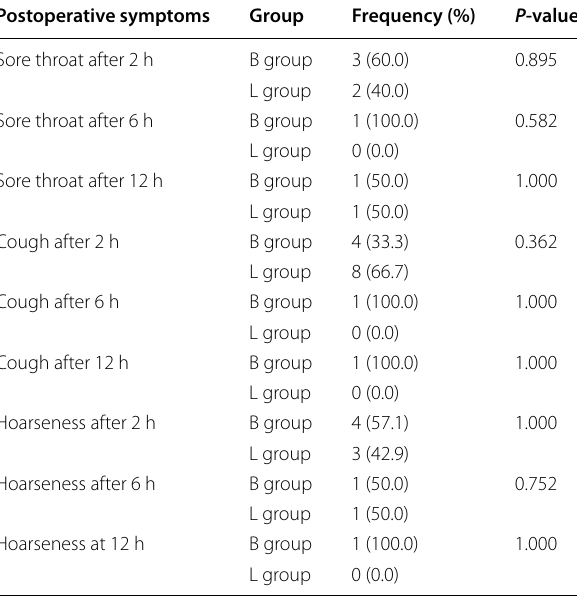
Table 2 Association of postoperative symptoms with both the groups